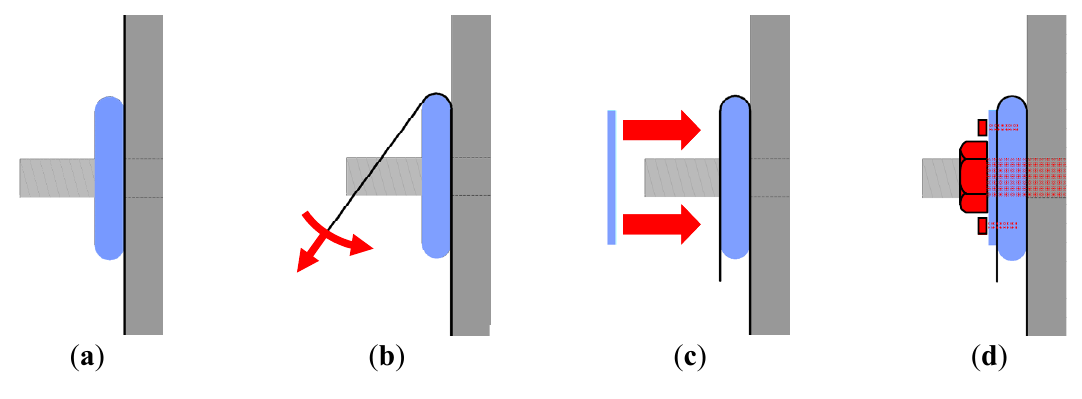
Figure 2. Mechanical anchorage of carbon mesh with aluminum profile. ( a ) Application of aluminum profile; ( b ) Pre-stressing the mesh fibers when wrapping them around the aluminum profile; ( c ) Fixation of mesh by metal plate; and ( d ) Fixation of aluminum profile and metal plate in adjacent concrete.